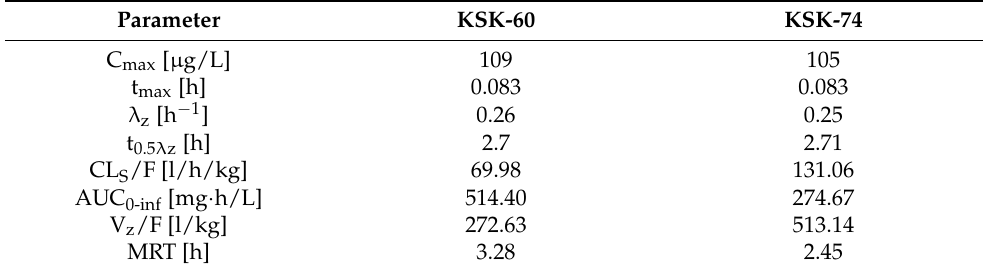
Table 3. Estimated pharmacokinetic parameters (non-compartmental analysis) of the investigated compounds calculated from mean rat plasma concentration values ( n = 3) after administration of a single i.p. dose of 10